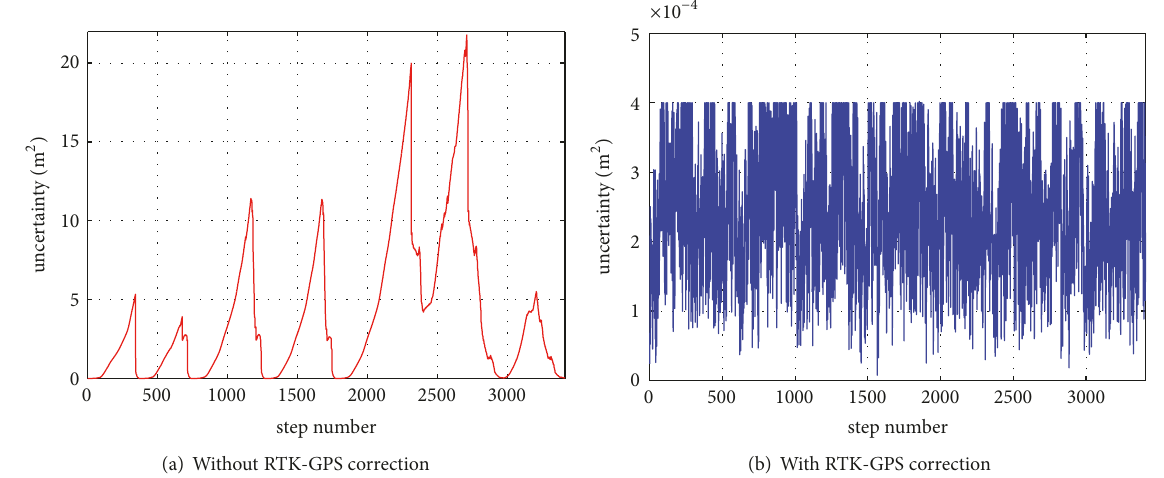
Figure 13: Vehicle position